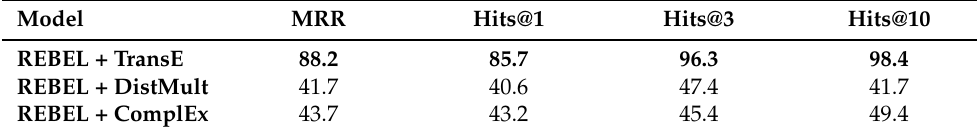
Table 3. Results of the evaluation using REBEL combined with each embedding